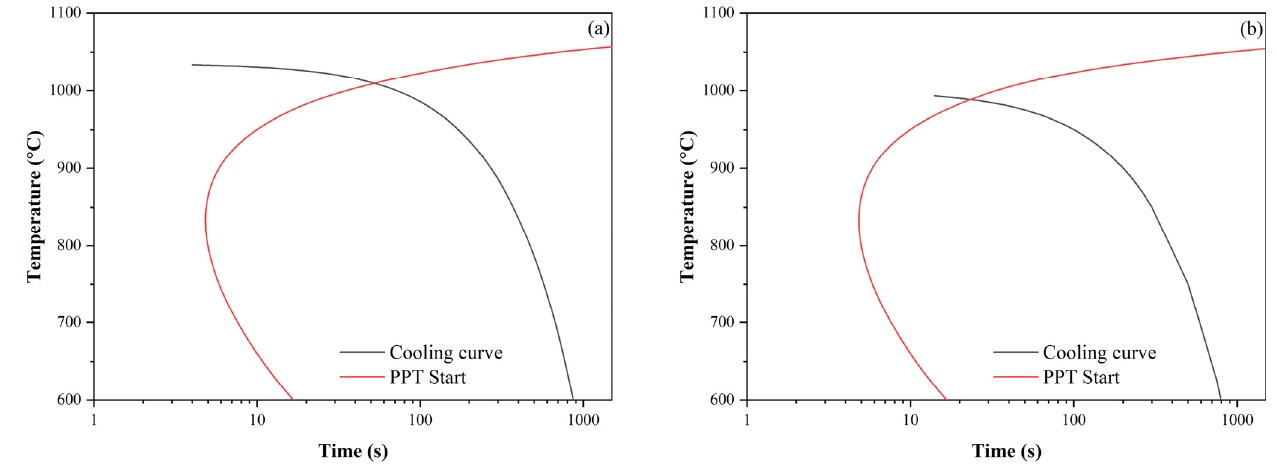
Figure 19. Interaction of cooling curves and precipitation onset curve: ( a ) variant 1 and ( b ) variant